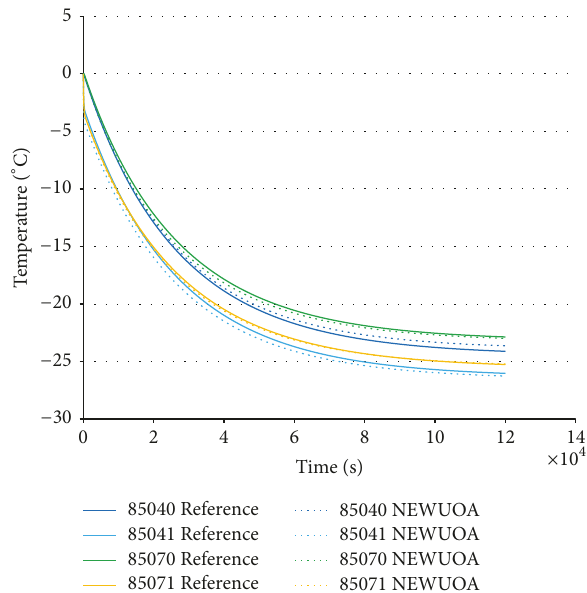
Figure 9: Transient cold case. Temperatures obtained from correla- tions with NEWUOA.